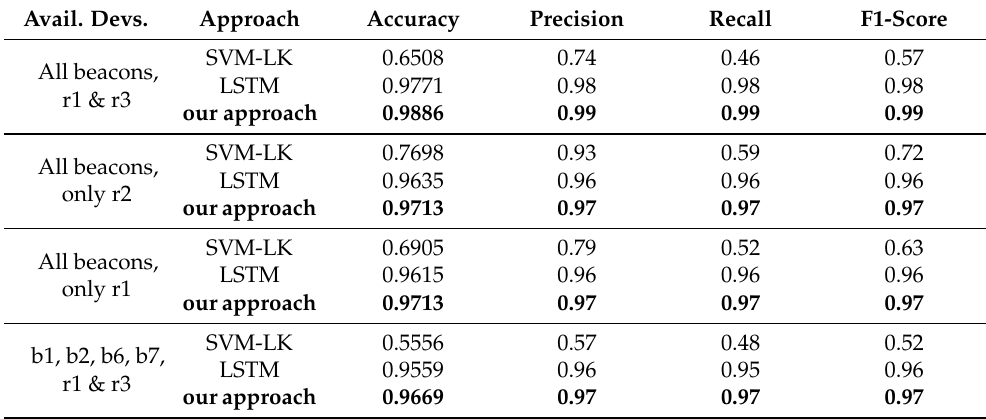
Table 2. Performance comparison of our approach with the method proposed in [27] and with the LSTM network, in “degraded network conditions” (dropped receivers and/or beacons). The first column indicates which devices were available in each degraded configuration (i.e., the devices that are not indicated were dropped). r1, r2, r3 are the receivers and b1,. . ., b7 are the beacons. Figures in bold refer to the best performing